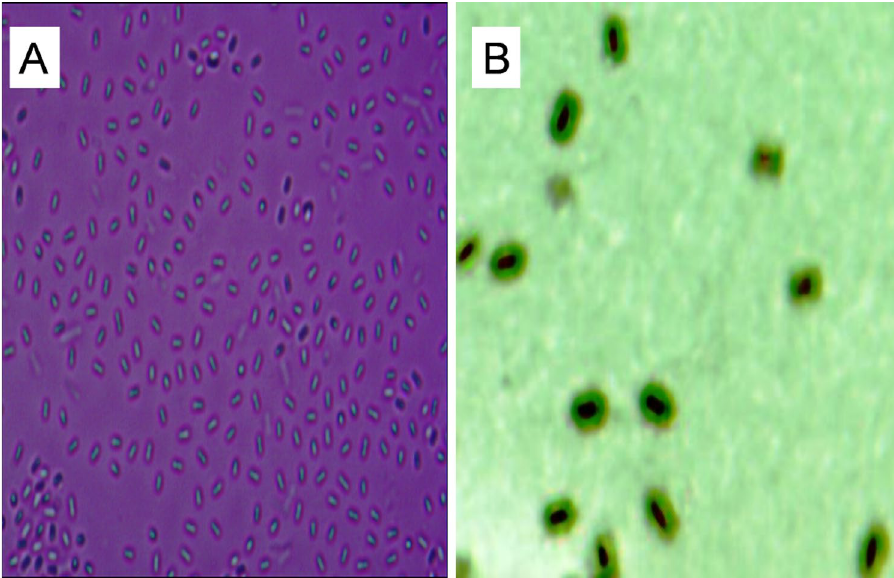
Figure 1. The microgram of Bacillus subtilis xztubd1. Magnification: 100 × ( A ) and 400 × ( B